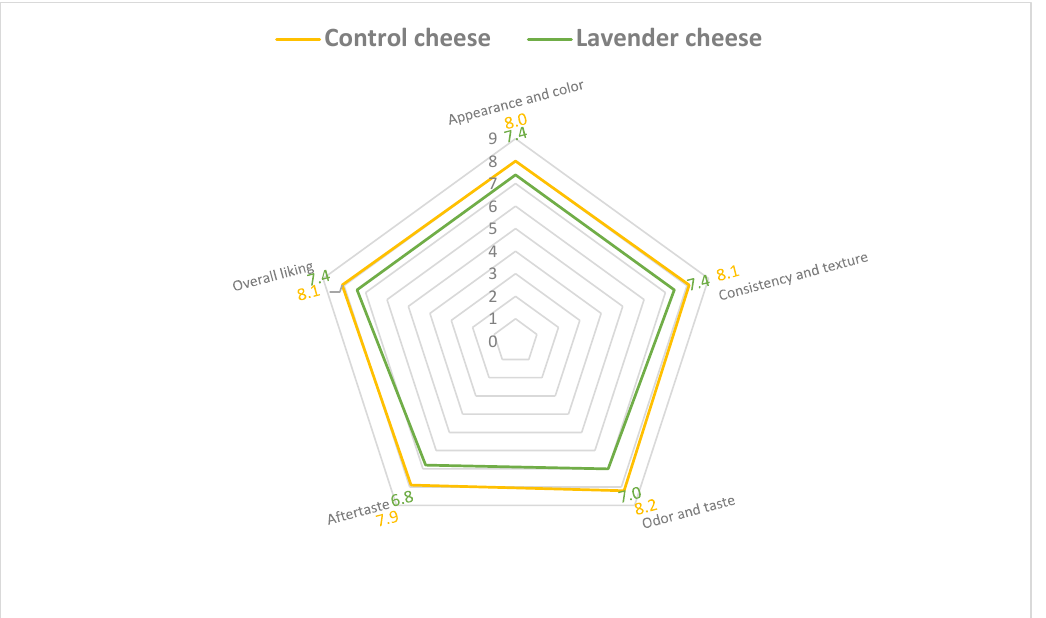
Figure 4. Hedonic scores for sensory attributes of control and lavender Gouda-type cheese. Data are expressed as mean values of all responses.